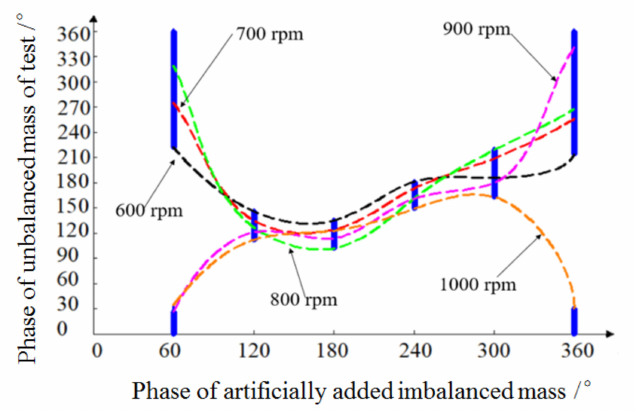
Figure 9. Threshing drum end face radial weight unbalance phase change